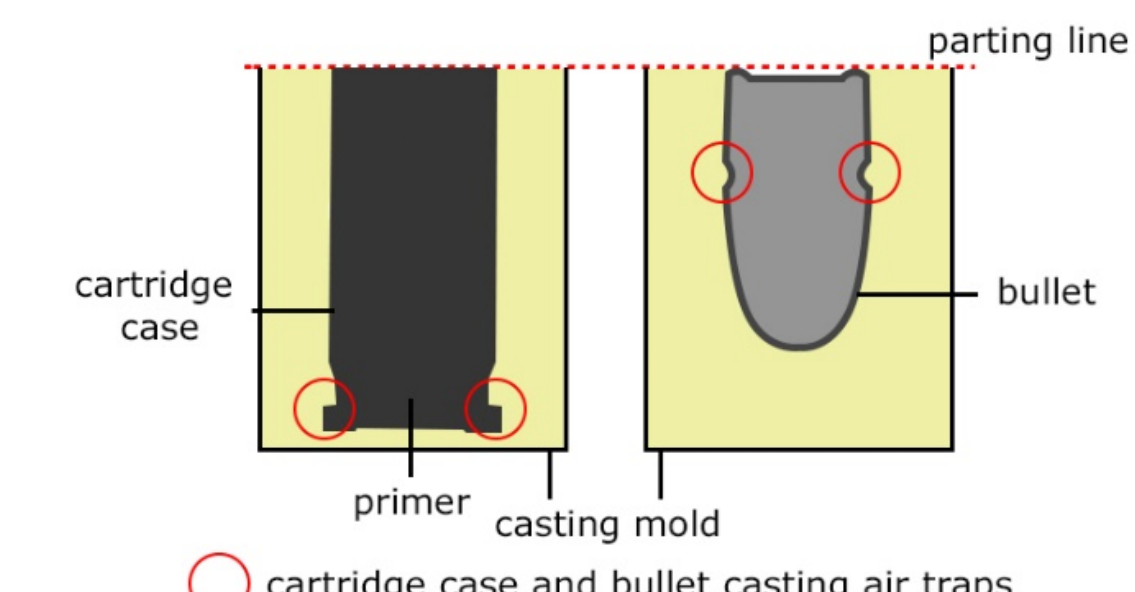
Figure 7. Schematic view of areas in the molds responsible for air traps and surface defects of the bullets and the cartridge case replicas.